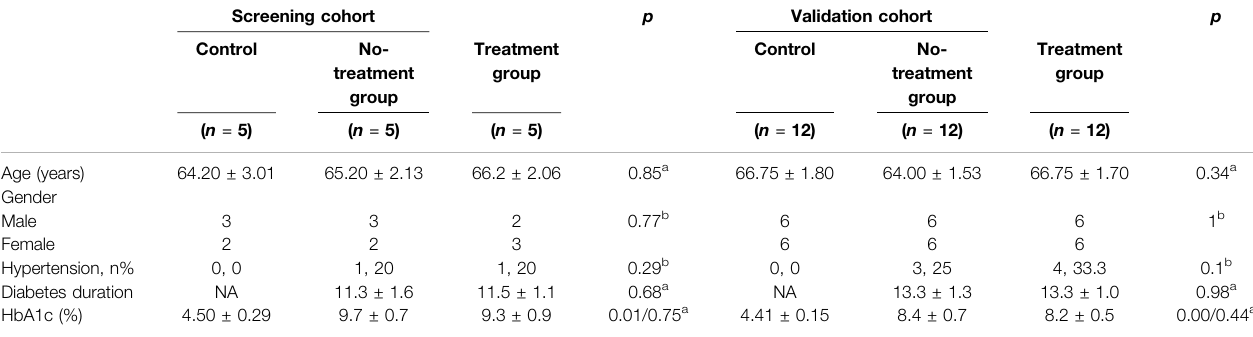
TABLE 1 | Demographic and clinical data of the study groups Screening